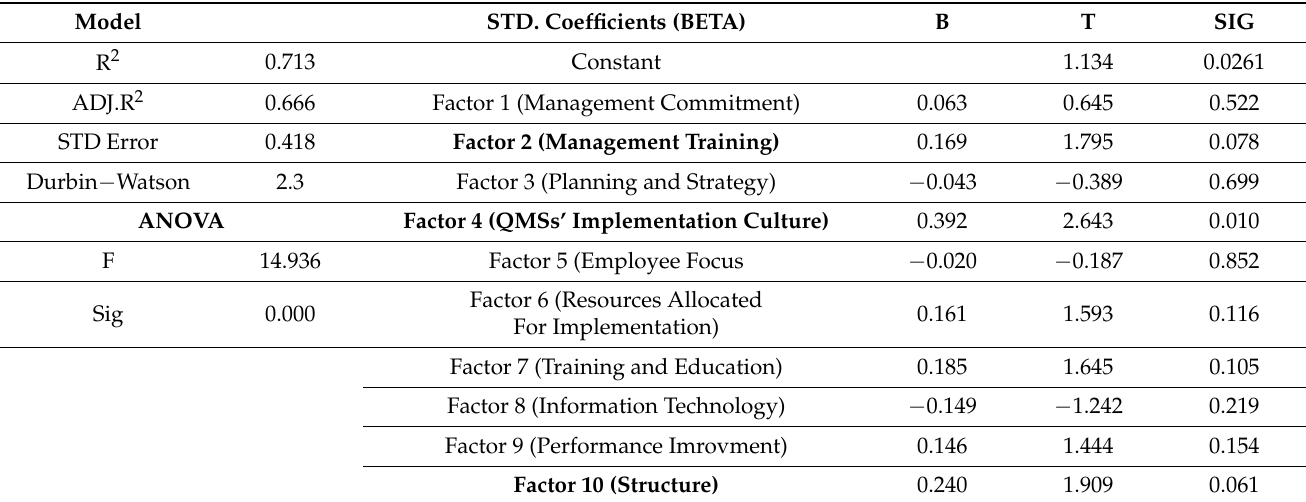
Table 6. Multiple linear regression